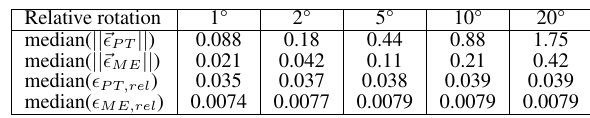
that is triangulated into a mesh (Fig. 6a). In addition, a line (red) is defined that separates the set of points into two parts where different rigid transformations are applied. The perpendicular foot points (green points) of the triangle center points are used as the target crack positions. The deformed state is visualized in Fig. 6b and c where the error vectors (Eq. 13 for Fig. 6b and Eq. 14 for Fig. 6c) are shown as vector fields (scale factor 10), too. The errors have a preferred direction along the crack and they are reduced if the model extension is used (shorter arrows). Figure 5. (a) Triangle split with relative shift and relative rotation; (b) vertices of M 1 in green and extended set of vertices M 2 in yellow; (c) color-coded mesh with values of || ⃗t rel || and deformation vector field (scale factor: 15) of a tension test with a relative rotation.